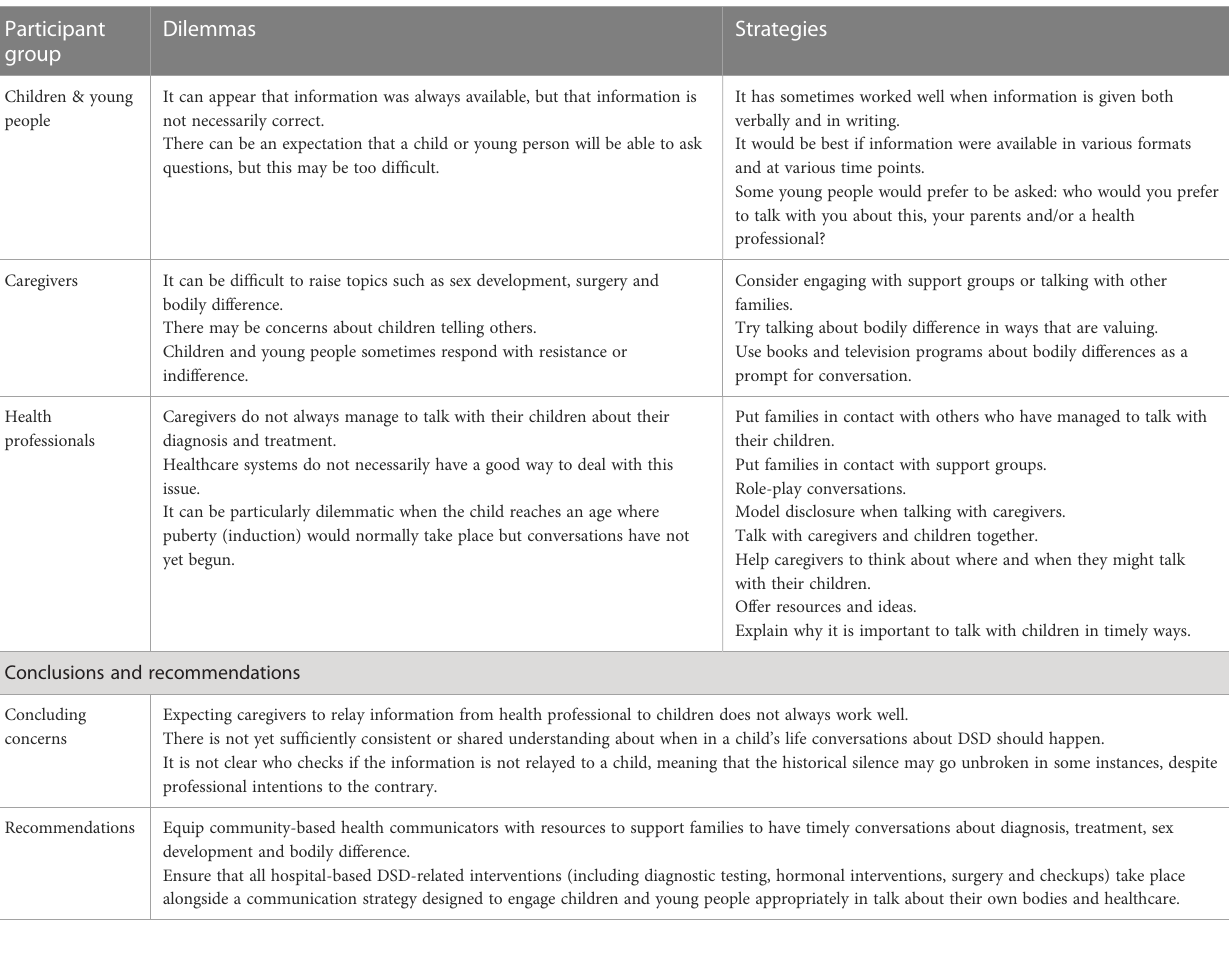
TABLE 3 Strategic communication approach for health professionals (Adapted from 9). Strategic